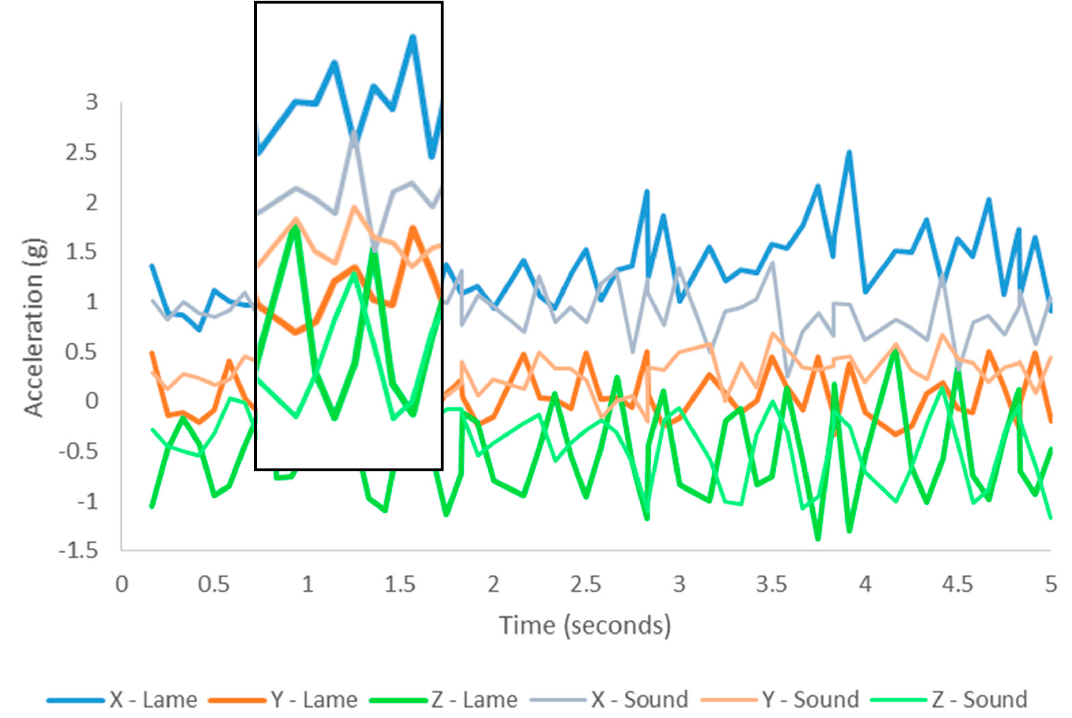
Figure 4. Raw ear acceleration signals for sound and lame walking. Note the increased amplitude of lame walking signals. Insert highlights the difference in amplitude between lame and sound walking signals.